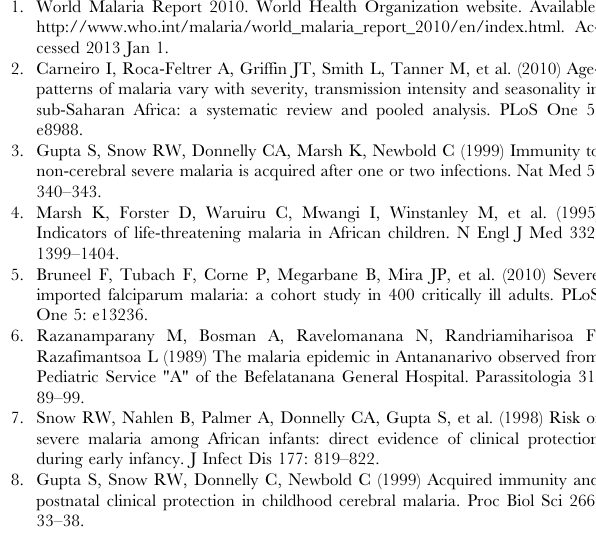
Figure S1 Distribution and mean age at admissions with severe malaria within the cohort during the study period 2002–2010. Severe malaria admissions were included up to 2010, i.e. 2 years after inclusions ended. (TIF) Figure S2 Distribution of alleles of A) FC27 types and B) IC types in admissions and three-monthly visits. The y- axes determine the number of alleles of the same fragment length at base pair precision. (TIF) File S1 Additional information of msp2 genotyping profiles and allele frequencies in visits and